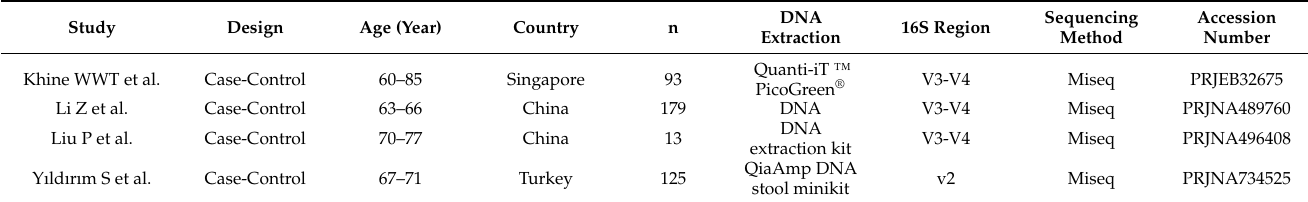
Table 1. Characteristics of human fecal samples used in the present